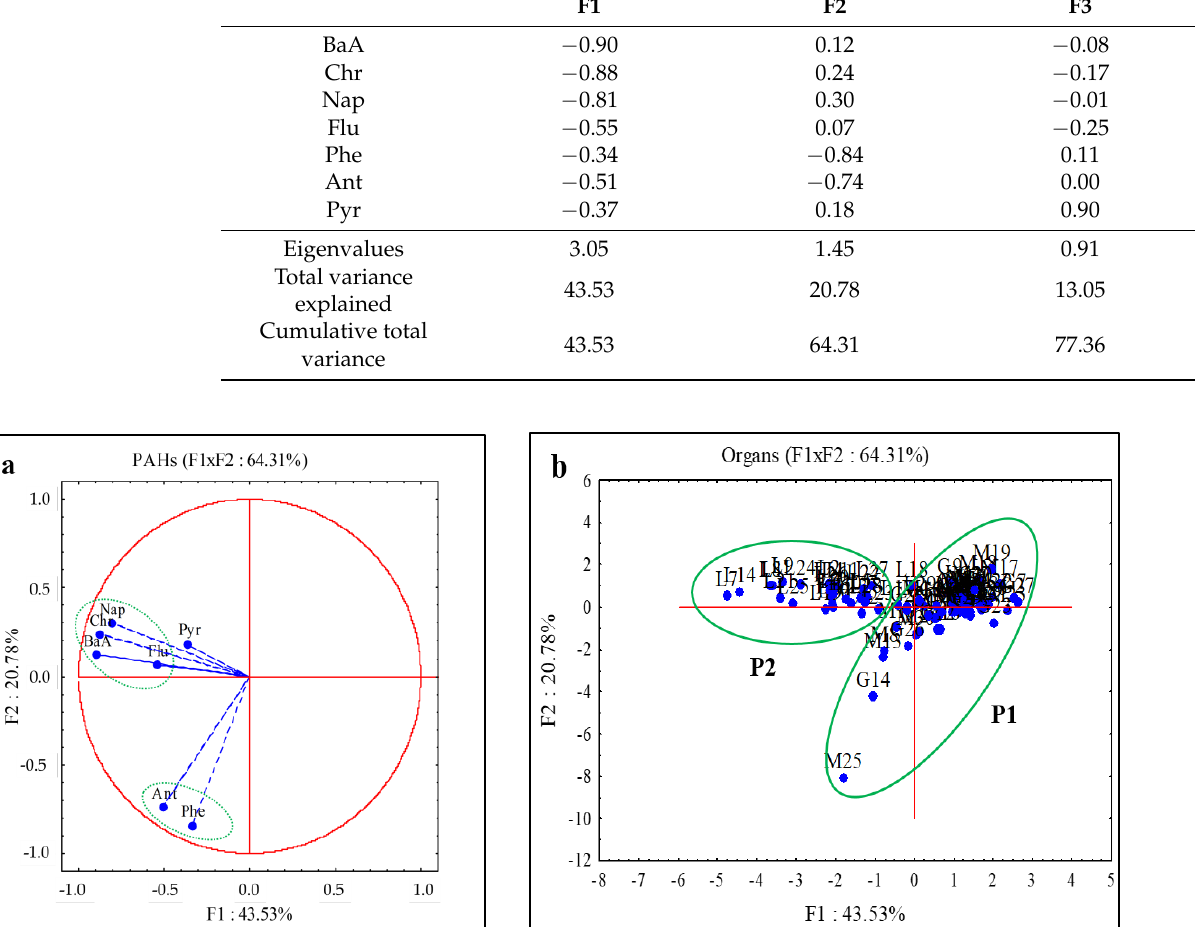
Figure 5. Projection of variables (PAHs) ( a ) and observations (Organs) ( b ) in the factorial plane F1 × F2 (M: muscle, G: gills, L: liver).